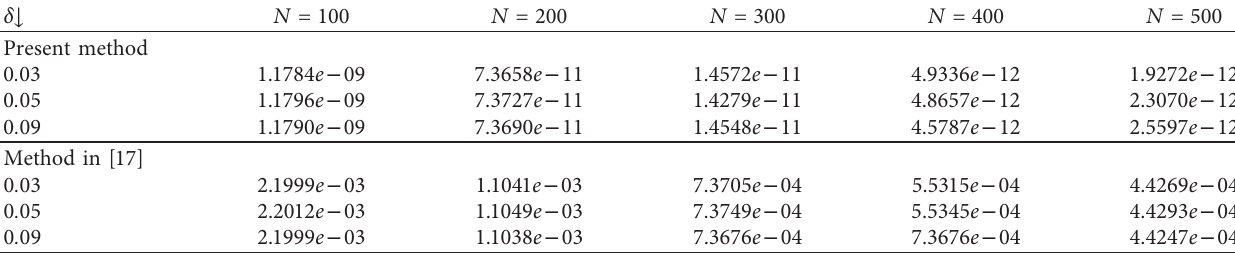
Table 1: The maximum absolute errors of Example 1 for different values of δ with ε � 0 . 1 .